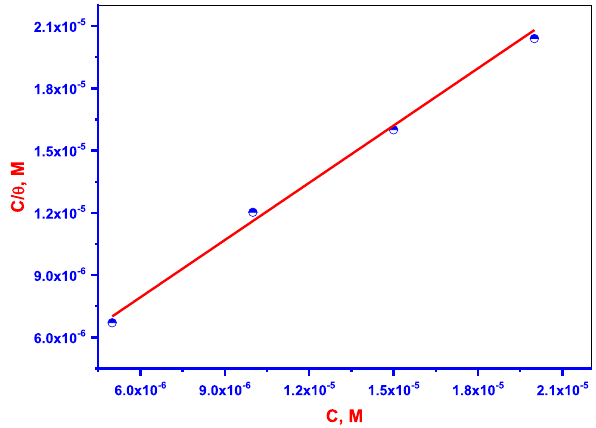
Figure 8. Langmuir AI for DTG at 30 °C.